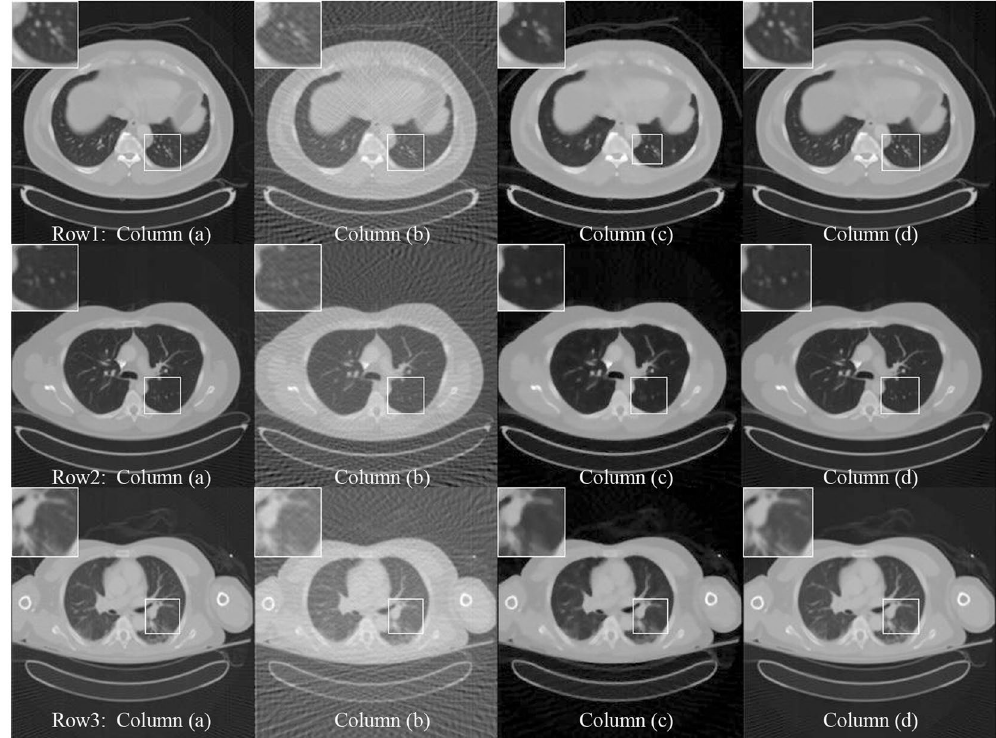
Figure 3. The 256 * 256 CT images reconstructed by 120 projection views. Column ( a ) shows the reconstruction by the FBP method from the full projection views. Column ( b ) shows the reconstruction by the FBP method from the sparse projection views. Column ( c ) shows the reconstruction by the ADS-POCS method from the sparse projection views. Column ( d ) shows the reconstruction by the proposed method.